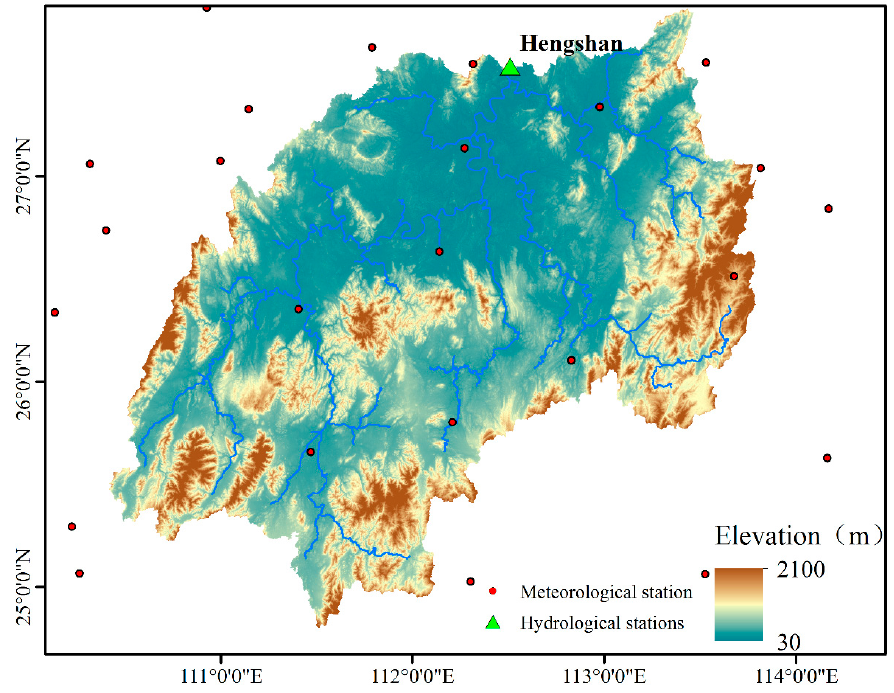
Figure 1. Study basin and locations of the hydrological station and meteorological stations.